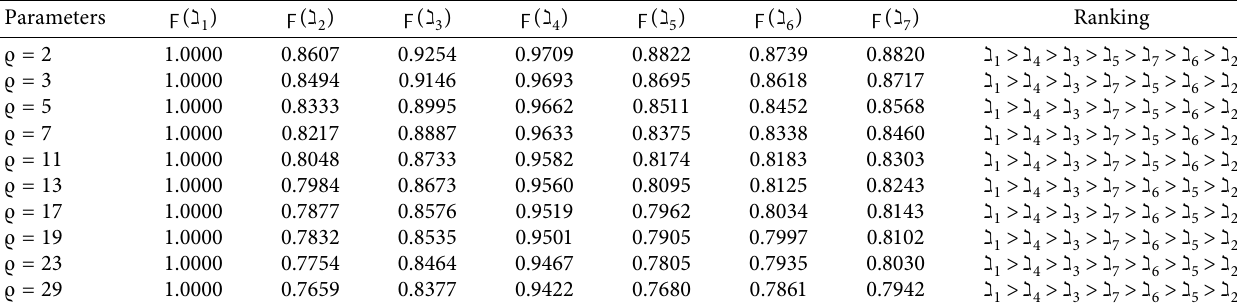
Table 12: Score values and ranking outcomes according to the parameter ϱ by the 2TLC q -ROFHWA operator. Parameters